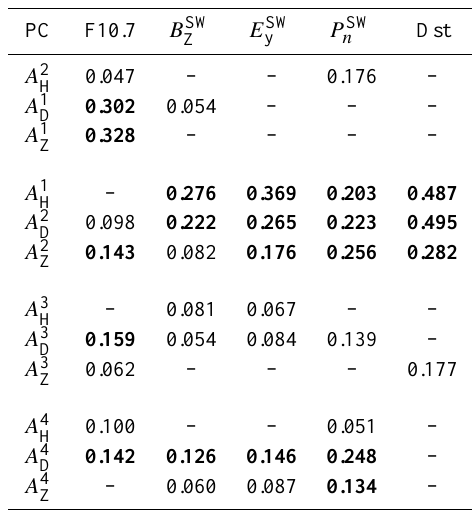
Table 1. The Pearson’s correlation coefficient | r | . The “–” refers to values less than the fixed 5% null-hypothesis threshold value. Bold values identify correlation values higher than 3 times the 5% threshold